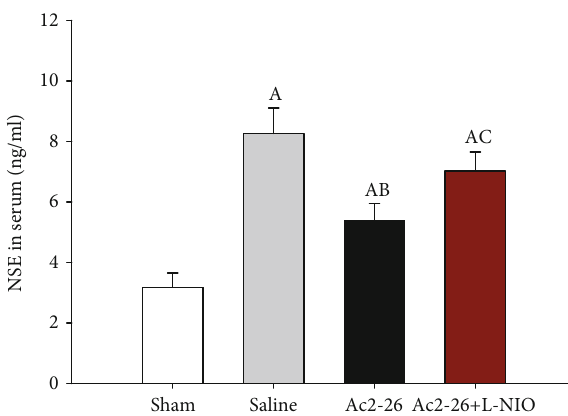
Figure 4: Serum NSE levels after ROSC. Serum NSE levels were detected using ELISA 72 hours after ROSC. Data are presented as mean ± SD . A P < 0 : 05 vs. sham group; AB P < 0 : 05 vs. saline group; AC P < 0 : 05 vs. Ac2-26 group (, sham group; , saline group; , Ac2- 26 group; , Ac2-26+L-NIO